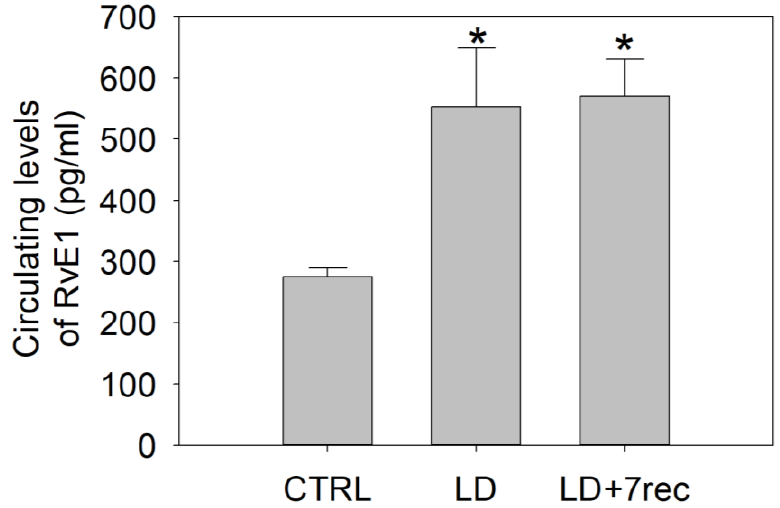
Figure 6. Quantification of RvE1 in the serum of LD rats. ELISA assay was performed on serum samples from all experimental groups. Statistical analysis was performed by one-way ANOVA test followed by Tukey test. Data are shown as mean ± SE ( n = 4). * p < 0.05 versus CTRL. CTRL (Control); LD (Light damage); LD + 7rec (Light damage + 7 days of recovery).